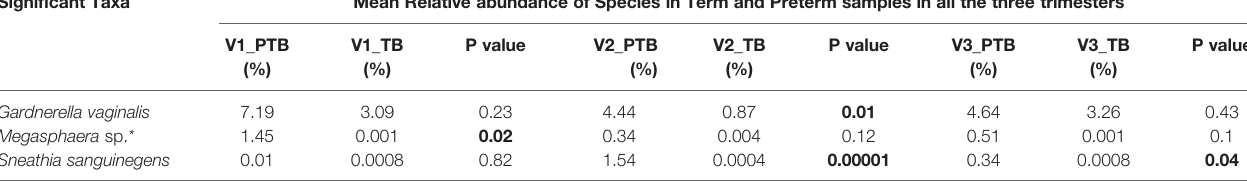
TABLE 4 | Non-Lactobacillus sp. in vaginal environment. Signi fi cant Taxa Mean Relative abundance of Species in Term and Preterm samples in all the three